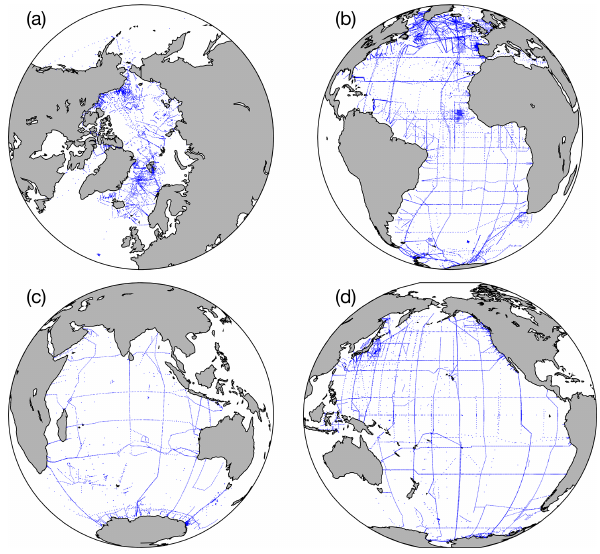
Figure 9. Locations of stations included in the (a) Arctic, (b) At- lantic, (c) Indian, and (d) Pacific ocean product files for the com- plete GLODAPv2.2020